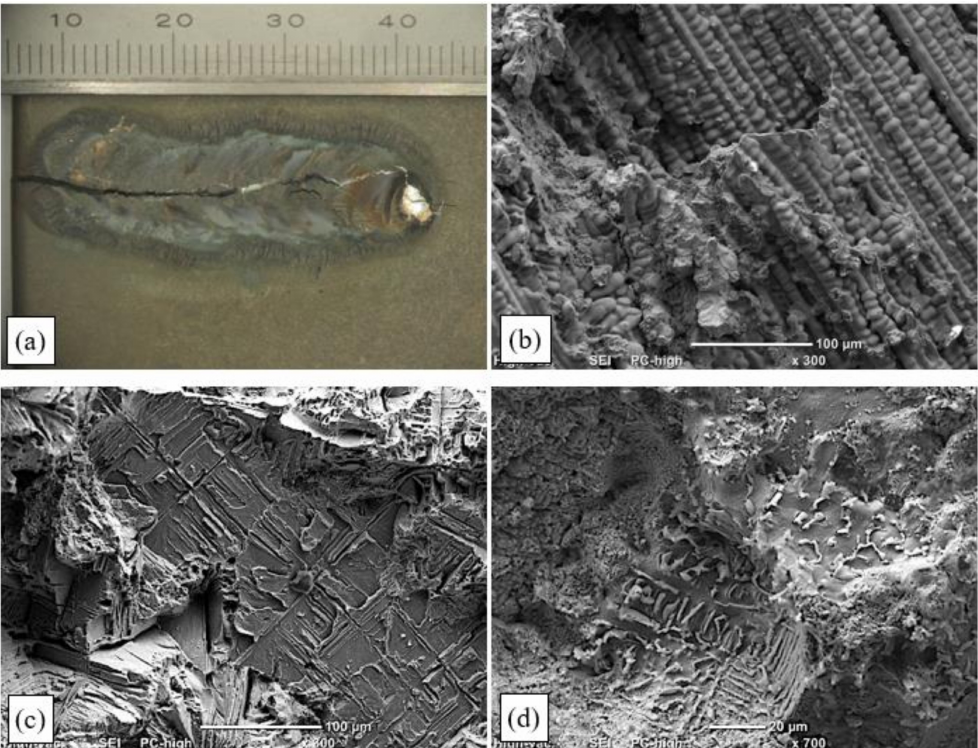
Figure 17. Results of fractographic examinations of the surface of a hot crack that developed during a transvarestraint test in a specimen subjected to 5% strain during remelting: ( a ) general view; ( b ) ruptured dendrites and interdendritic bridges in the remelted area; ( c ) crack surface with visible brittle transcrystalline fracture and areas of liquid film rupture; ( d ) partially melted carbides in the partially melted